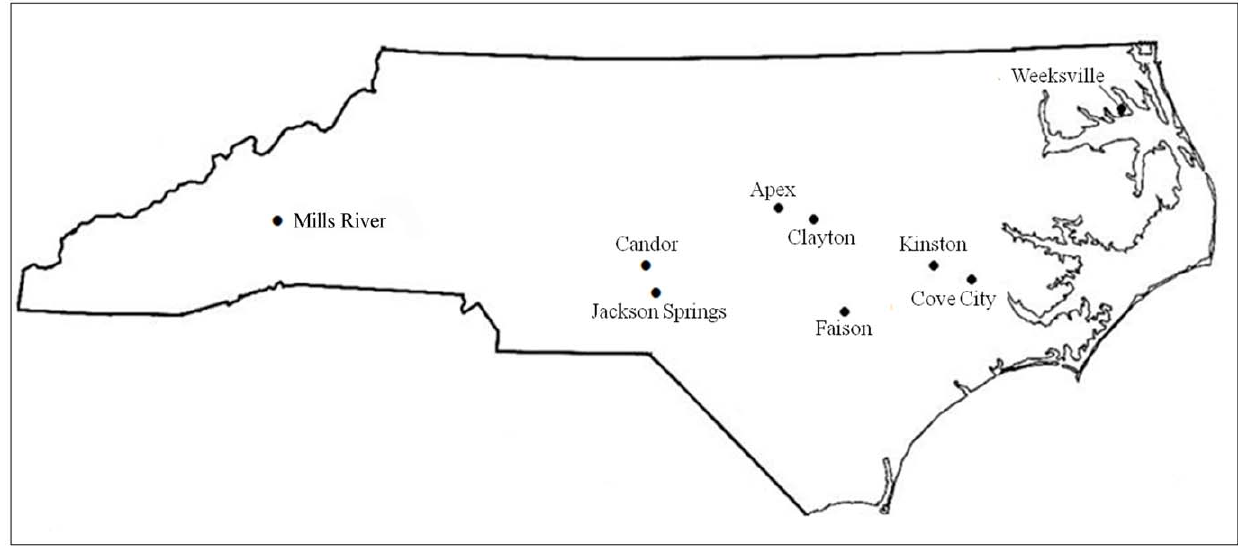
Figure 1. Map of collection locations for Thripstabaci individuals and Tomatospottedwiltvirus isolates.